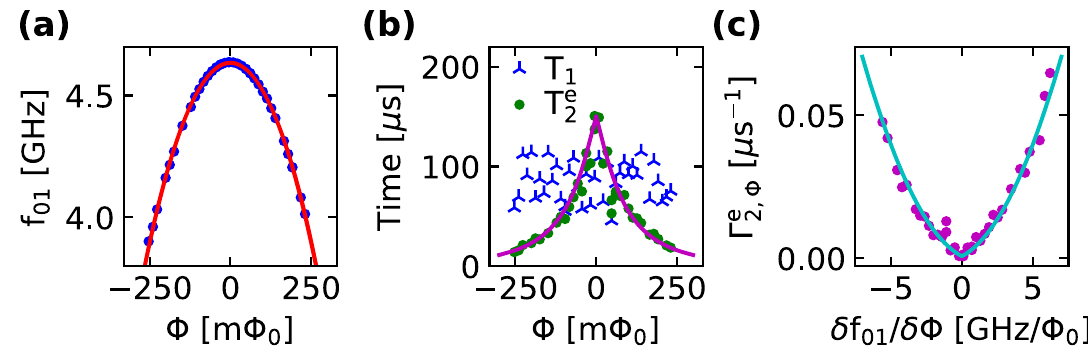
Fig. 2 Impact of fl uxnoise on coherence. Flux ( Φ ) dependent measurements are used to determine coherence parameters related to fl uxnoise. a Qubit frequency as a function of Φ . b T of the fl ux